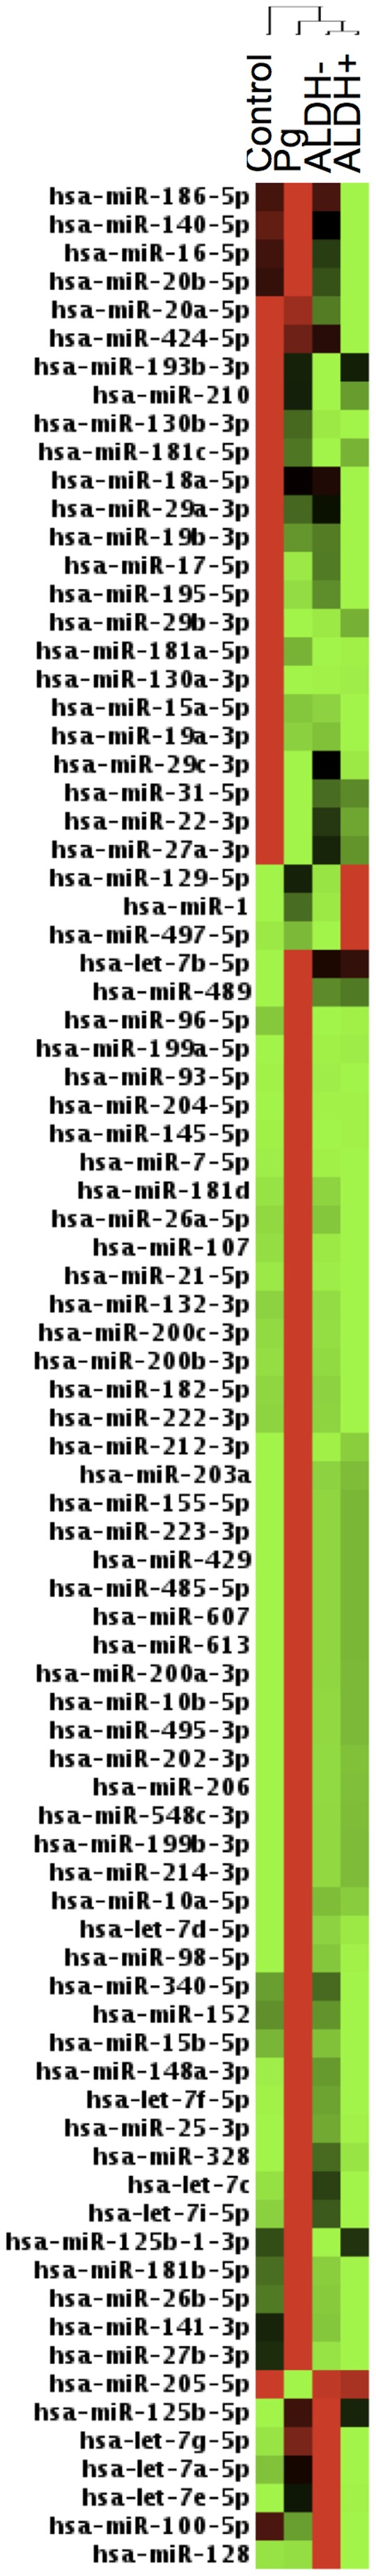
Heatmap of microRNA expression in MCF10A cells.Each column represents one experimental group and each row represents one microRNA. microRNAs were arranged by unsupervised hierarchical clustering. Green and red indicate down- and upregulation, respectively, relative to the overall mean expression for each microRNA. The four experimental groups were: 1) non-irradiated cells (control); 2) cells exposed to progesterone treatment alone (Pg); 3) ALDH− cells and 4) ALDH+ cells after irradiation and progesterone treatment.